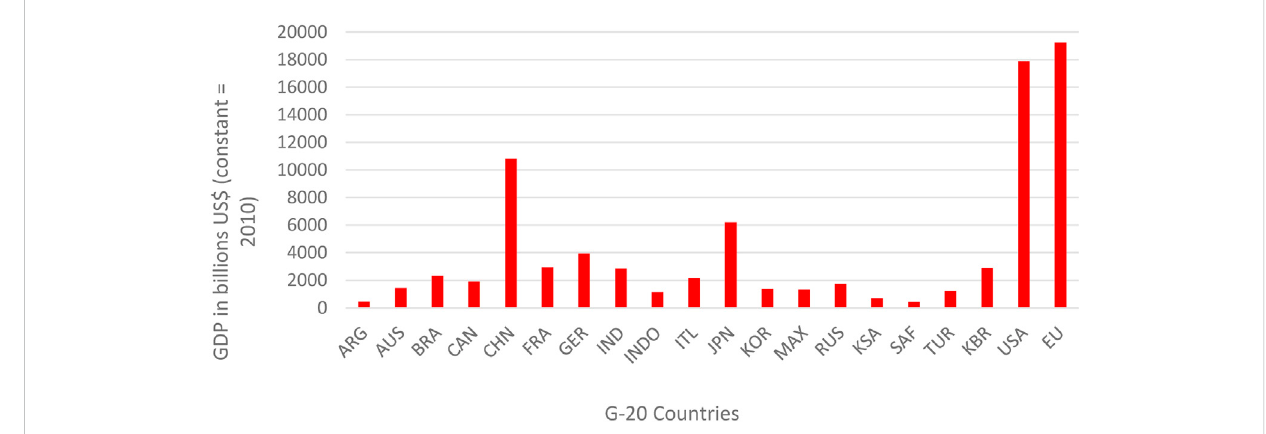
FIGURE 1 GDP of G-20 countries based on 2018 in billions of US$ (constant = 2010).